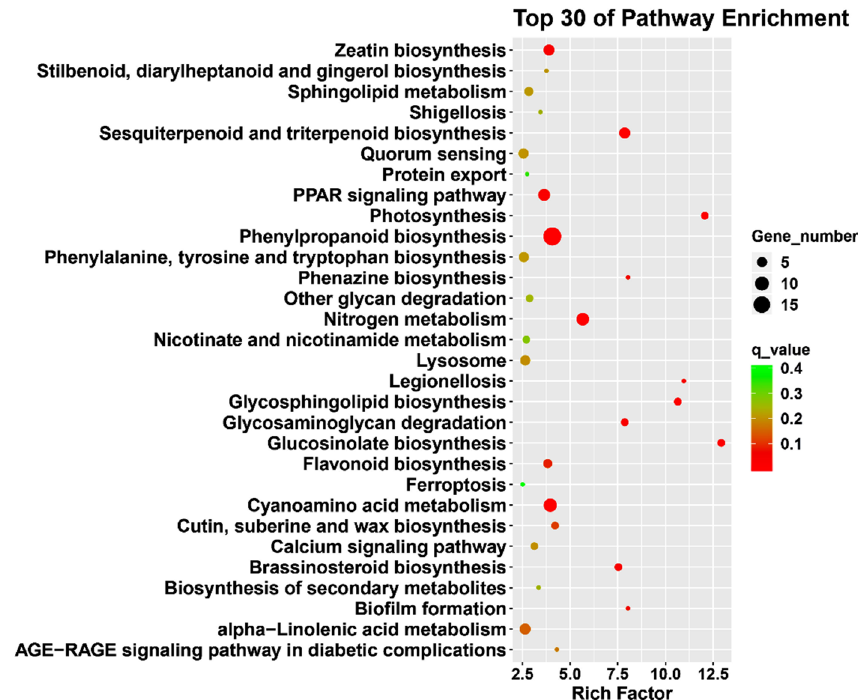
Figure 5. KEGG enrichment analysis of differentially expressed genes under high-temperature treatment. The figure shows the top 30 pathways. The size of the dot indicates the number of DEGs involved in the pathway. The color scale indicates the significance level (q-value ≤ 0.05). The rich factor is the ratio between the number of DEGs and all genes enriched for the